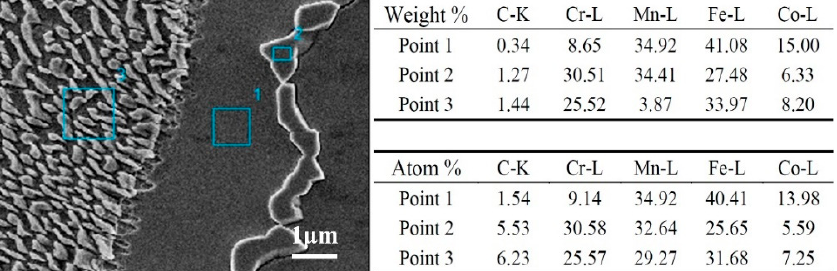
Figure 3. EDS diagram of the 0.5C-AC specimen. The table in the figure represents the mass fraction and atomic ratio of the test point, respectively.